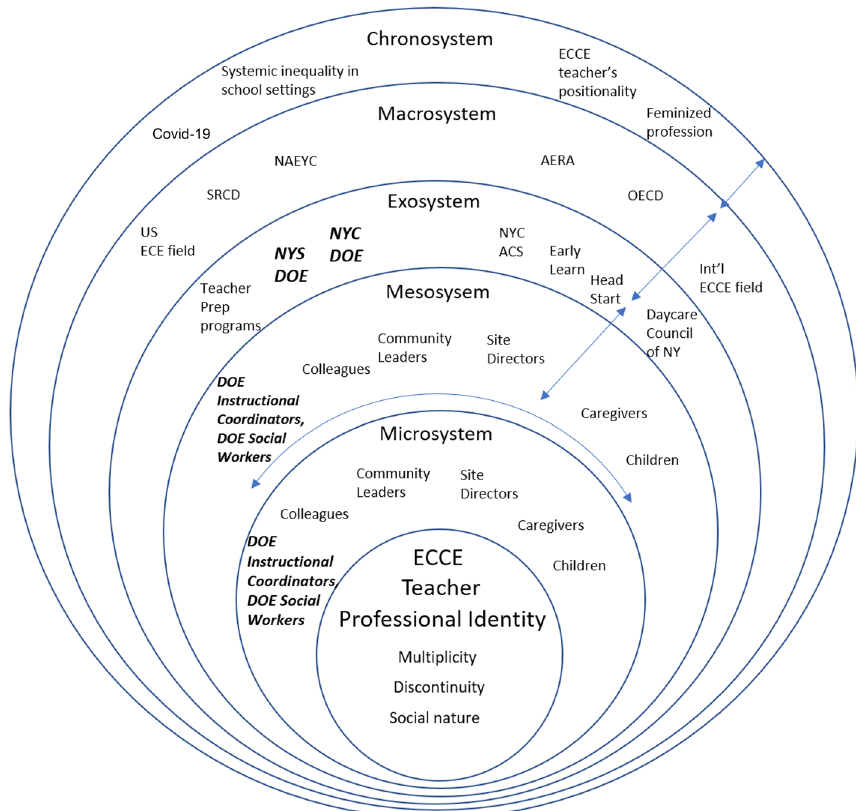
Fig. 1 Ecological system of ECCE teacher professional identity at NYC